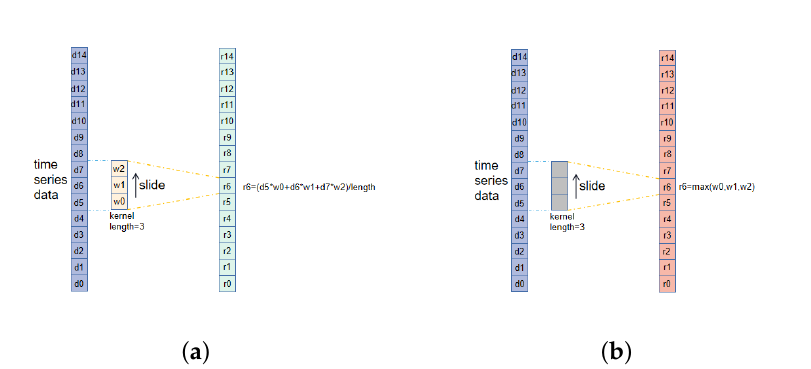
Figure 5. One-dimensional convolution and and max pooling process. ( a ) One-dimensional convolu- tion process, ( b ) One-dimensional max pooling process.